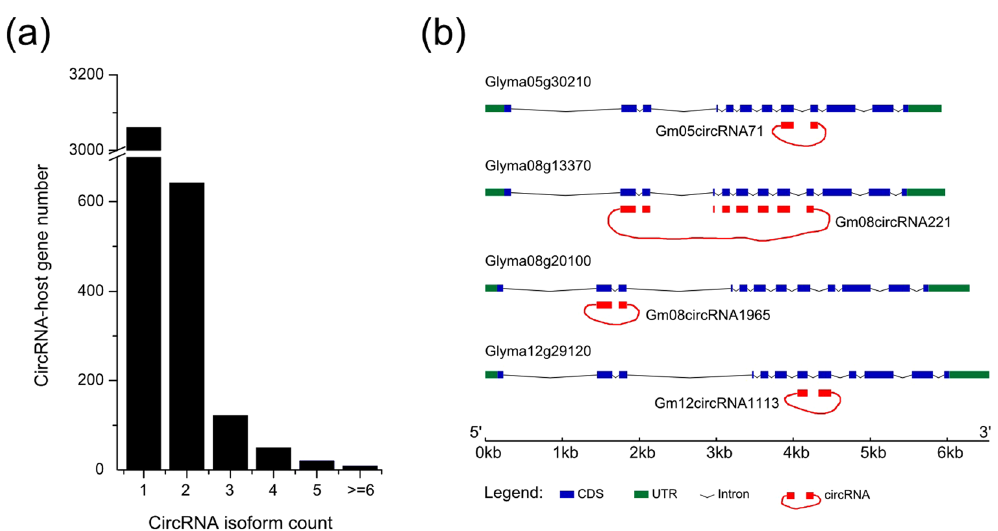
Figure 3. CircRNA-host gene and paralogous circRNAs in soybean. ( a ) Number of circRNA-host genes that generated different count of circRNAs in soybean. ( b ) A schematic plot of paralogous circRNAs. Paralogous circRNAs marked as red were showed below the structure chart of each paralogous